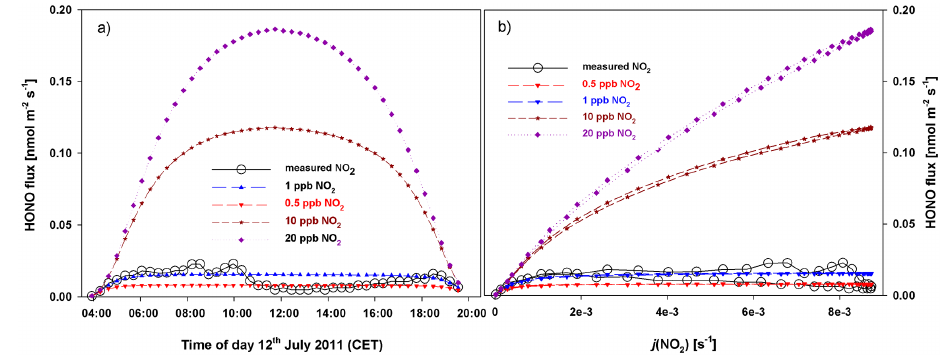
Figure 4. Diurnal cycles of HONO emission fluxes caused by light-induced NO 2 conversion for different NO 2 mixing ratios are shown in panel (a) . The corresponding correlations of HONO formation with j (NO 2 ) are presented in panel (b)